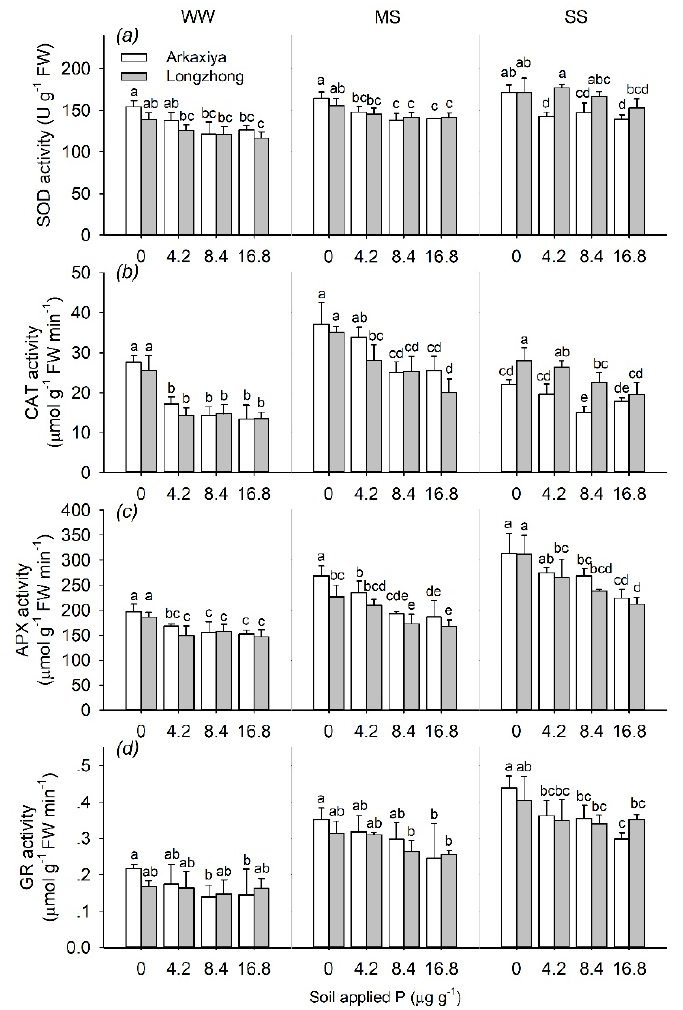
Figure 6. Activity of superoxidae dismutase (SOD) ( a ), catalase (CAT) ( b ), ascorbate peroxidae (APX) ( c ) and glutathione reductase (GR) ( d ) per gram fresh weight (FW) of leaves of two alfalfa genotypes, Arkaxiya (white bars) and Longzhong (grey bars), grown for 10 weeks with four P supply levels and three water treatments: (i) well-watered (WW); (ii) moderate water shortage (MS); and (iii) severe water shortage (SS). Values are means + one standard error of the mean ( n = 3). Values are means + one standard error of the mean ( n = 3). Different letters between bars represent significant differences between means at p < 0.05.